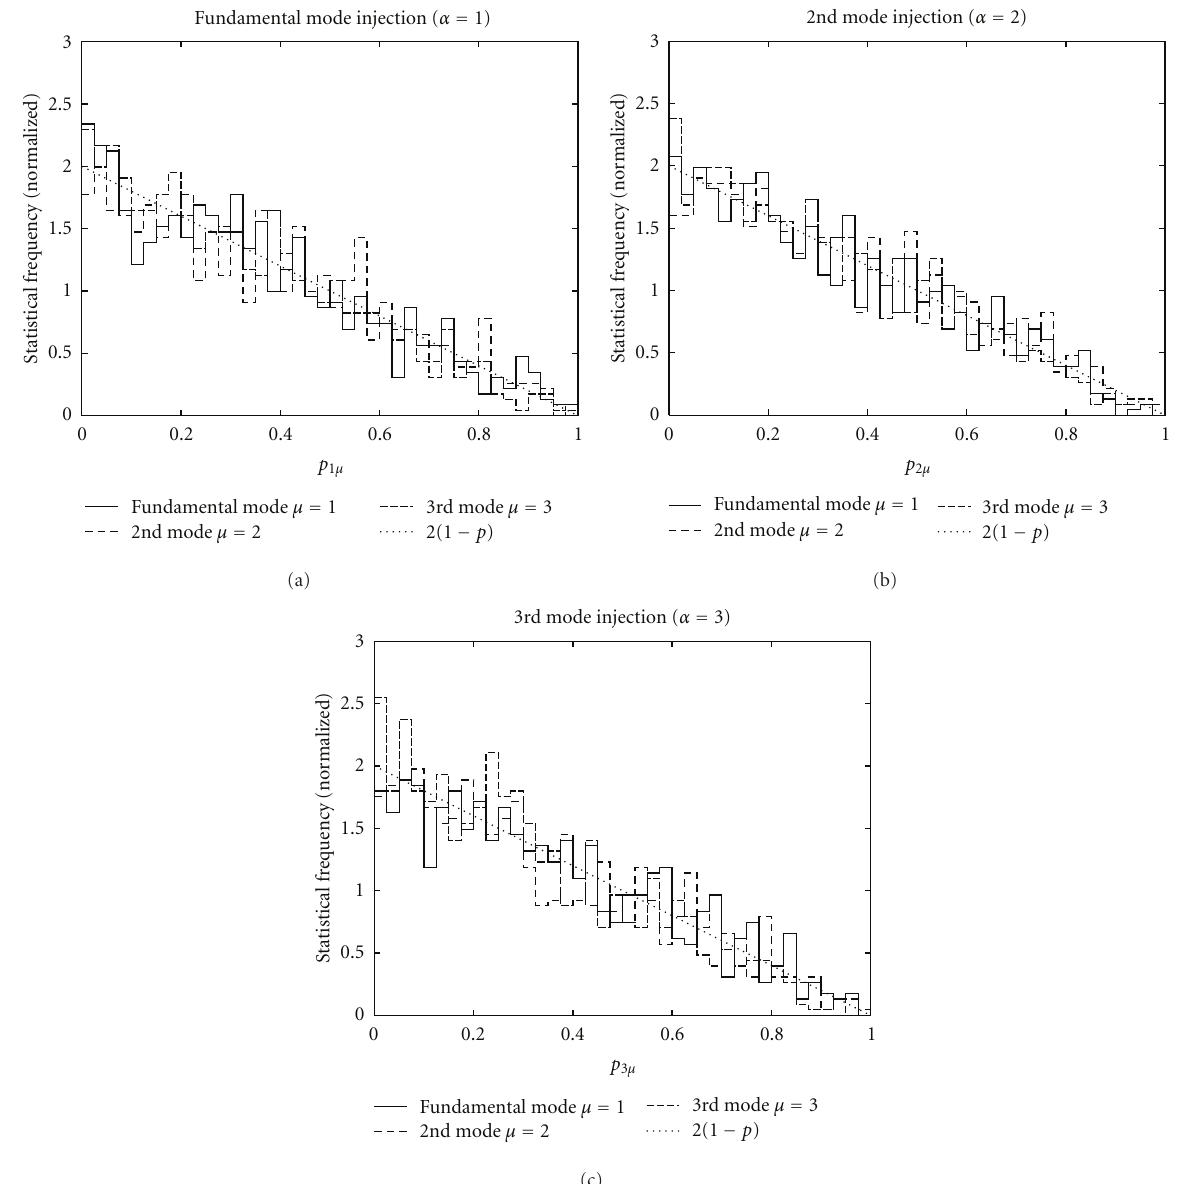
Figure 11: Frequency distributions for the fraction p αμ of each propagating mode in the transmission current carried by each propagating mode when each of three propagating modes is incident for Kd =